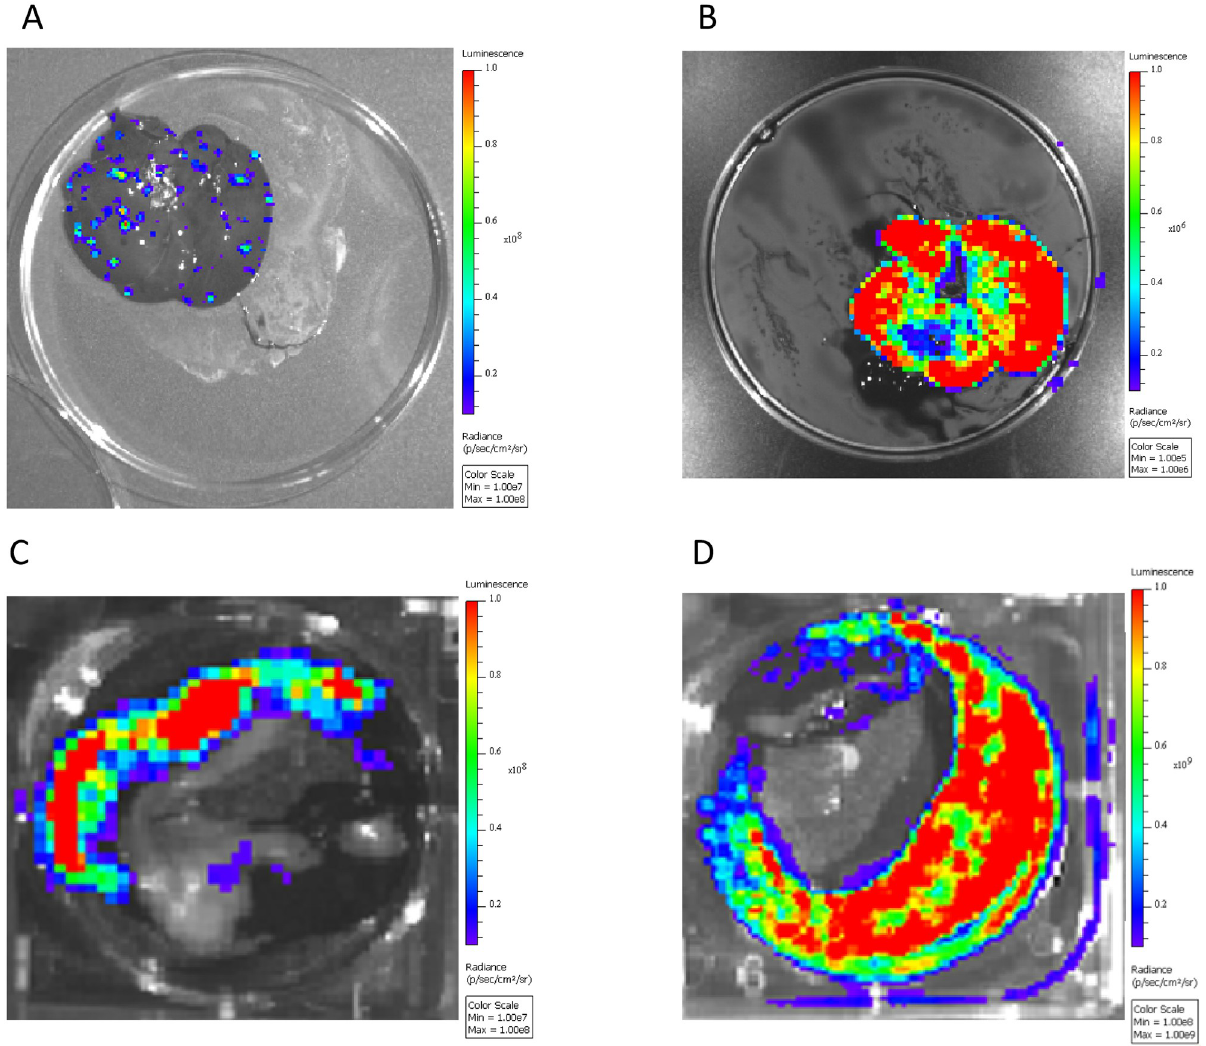
Fig 5. Diffuse vs uniform viral replication in organs. Prairie dogs infected with luc+ MPXV were imaged on indicated days, injected via intracardiac route with additional luciferase and immediately euthanized and necropsied. Organs were removed and imaged for presence of luciferase, representing areas of replicating MPXV. Images are black and white photograph of a representative set of organs from a single prairie dog taken at each time point overlaid with a false color representation of photon emission intensity as indicated by the scale on the right in ps -1 cm -2 sr -1 . A and C, Liver and spleen from an animals euthanized on day 9 and 11 respectively, representing diffuse multifocal MPXV replication. B and D, Liver and spleen from an animals euthanized on day 6 and 9 respectively representing uniform viral replication throughout the whole